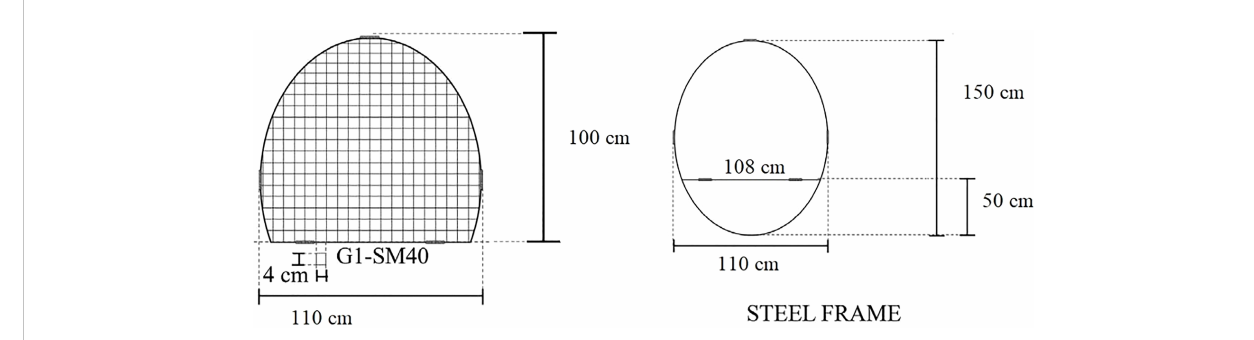
FIGURE 2 The sorting grid used during the bottom trawl campaign and its size features (modi fi ed from Vitale et al.,